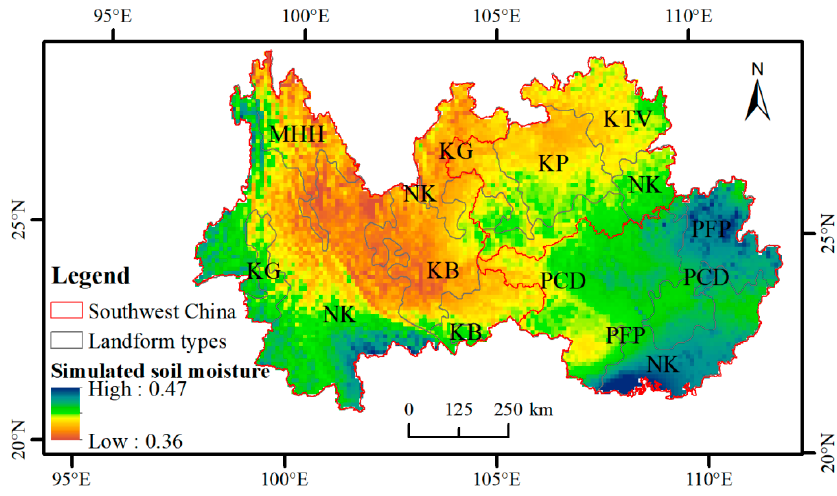
Figure 7. Simulated soil moisture in karst areas of Southwest China from 2000 to 2015 (PFP: peak forest plain; KG: karst gorge; NK: non-karst region; KB: karst basin; MHB: middle-high hill; PCD: peak cluster depression; KTV: karst trough valley; KP: karst plateau).